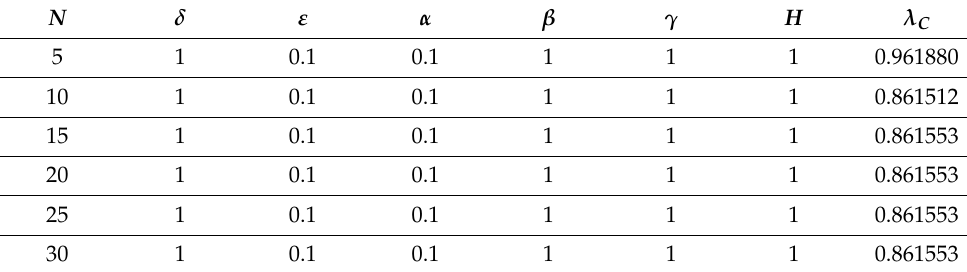
Table 6. Rapid convergence of the Spectral Weighted Residual